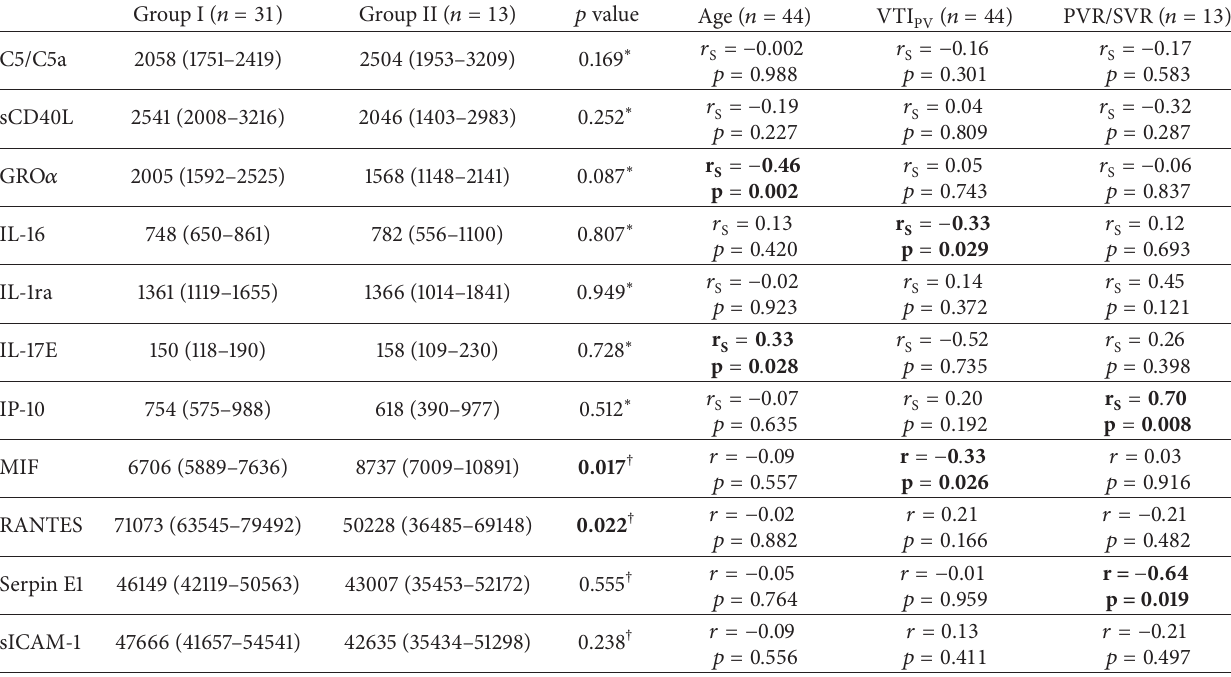
Table 2: Correlations of inflammatory mediators with clinical, echocardiographic, and hemodynamic